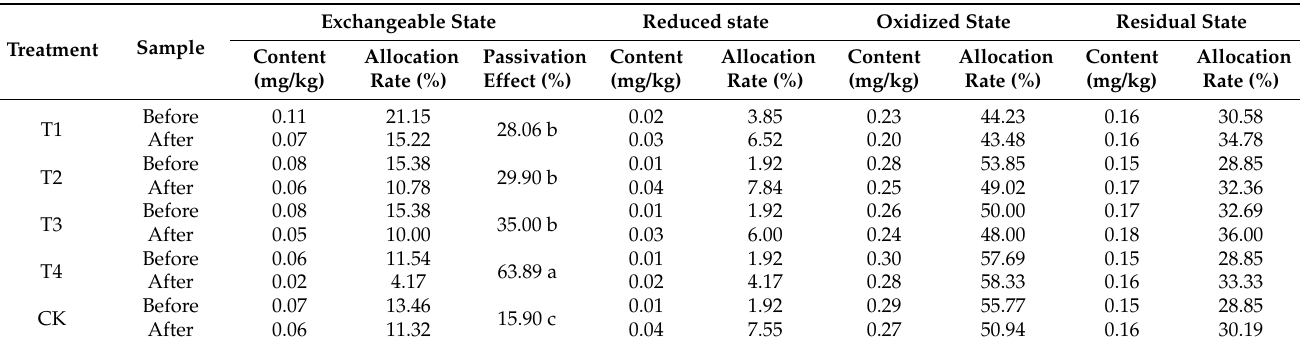
Before After Before After Before After Before After Before After Figure 2. Distribution rate of various forms of Zn before and after biogas residue composting. The relationship between the four forms and content of Cd in each treatment was oxidized state > residual state > exchangeable state > reduced state (Table 5). The content of exchangeable Cd decreased after composting, and the content of reduced Cd and residual Cd increased (Figure 3), indicating that the addition of biochar promoted the transformation of Cd from an active to weak form. Compared with CK, the distribution rate of exchangeable Cd in each treatment decreased more with the addition of biochar. The passivation effect of biochar on Cd increased as more biochar was added, and there was no significant difference among T1, T2, and T3 treatments (Table 5). Comprehensive analysis showed that the chemical inertness and aromatization of biochar determined that they could adsorb Cd 2+ through non-electrostatic physical adsorption with relatively weak ad- sorption affinity [21]. Studies have shown that biochar, humic acid, and peat were selected as passivation agents during composting, and biochar had the strongest passivation effect on the heavy metal Cd [22]. Combined with the results of this study, this indicates that biochar’s smaller particle size and larger specific surface area makes it better at adsorbing Cd 2+ . Table 5. Effect of biochar application on speciation of Cd during biogas residue